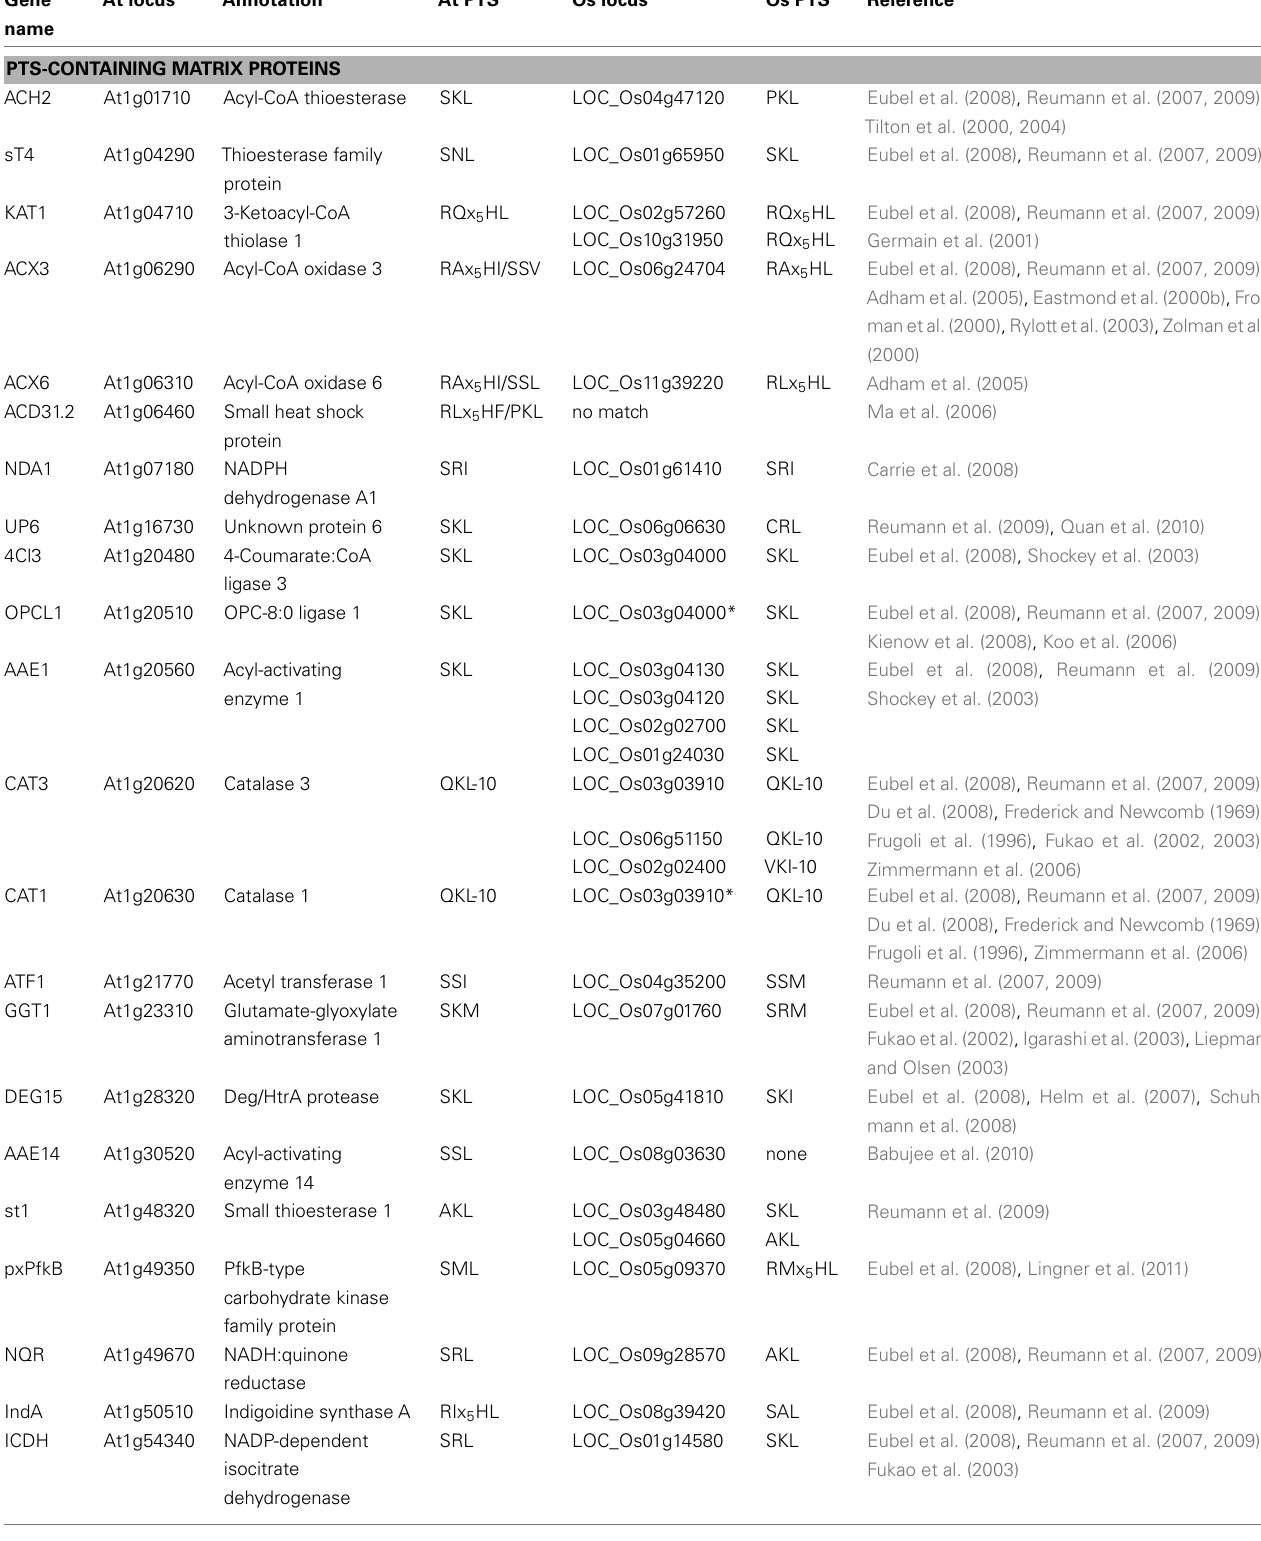
Table 1 | Peroxisomal proteins in Arabidopsis and